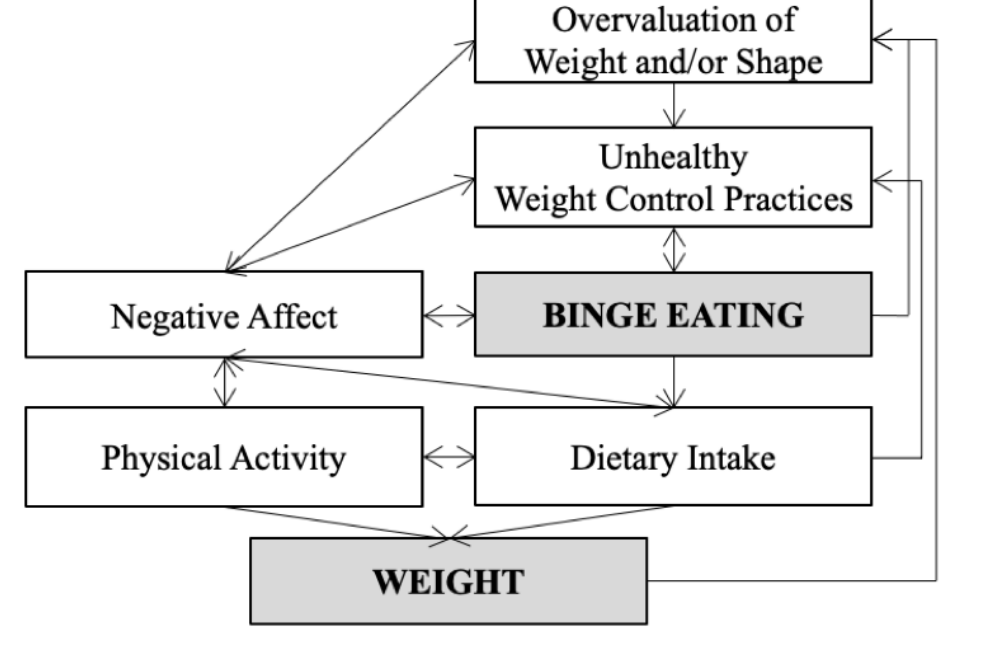
Figure 1. Theoretical model depicting the relation between binge eating and weight gain. The model integrates treatment targets (white boxes) in evidence-based treatments for obesity or binge eating [26-28]. Clinical outcomes are depicted in the gray